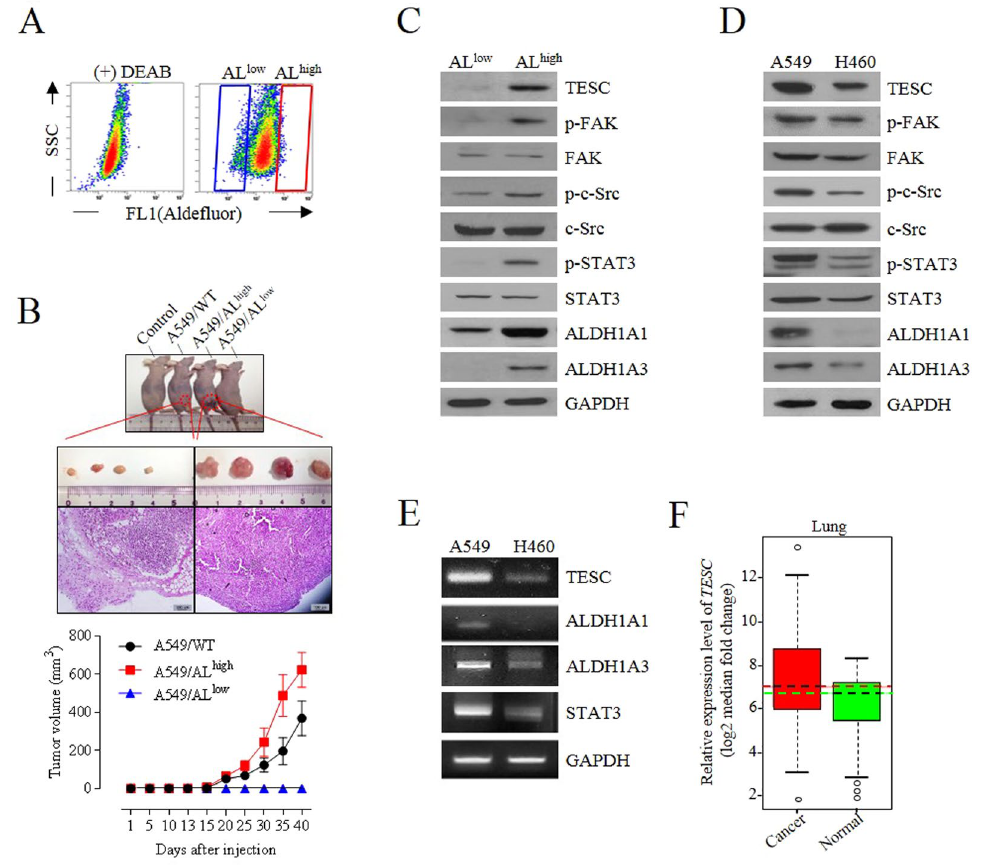
Figure 1. Cellular levels of TESC and phospho-STAT3 in ALDH1 high and ALDH1 low cell subpopulations of A549 NSCLC cells. ( A ) ALDH1 high and ALDH1 low cell subpopulations were sorted from A549 cells by using ALDEFLUOR staining and flow cytometry. ( B ) Tumorigenic capabilities of ALDH1 high and ALDH1 low cells were evaluated by mouse xenograft tumor growth assay. Tumor size was measured every 5 days and tumor volumes were calculated as (width) 2 × (length)/2 and presented as mean ± SD (n = 5 for each group). Histology of xenograft tumor sections was examined by hematoxylin/eosin (H&E) staining. ( C , D ) Cellular levels of TESC, p-STAT3, p-c-Src, and p-FAK were examined using western blot analysis in ALDH1 high and ALDH1 low NSCLC cells, or in A549 and H460 NSCLC cells. ( E ) RT-PCR analysis of TESC, ALDH1 and STAT3 in A549 and H460 cells. ( F ) Gene expression analysis of TESC in lung normal and cancer tissues using using a public database GENT (gene expression database across normal and tumor tissues;